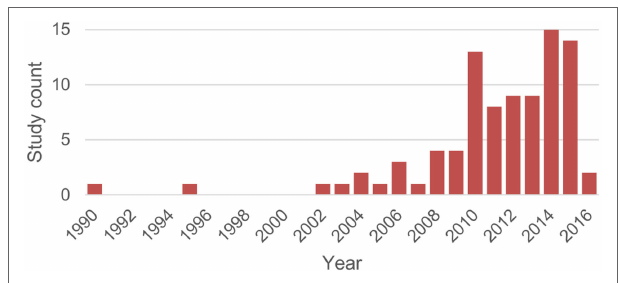
FiGURe 2 | Distribution of publication dates for the 87 papers reviewed involving multicriteria decision analysis in urban energy system planning